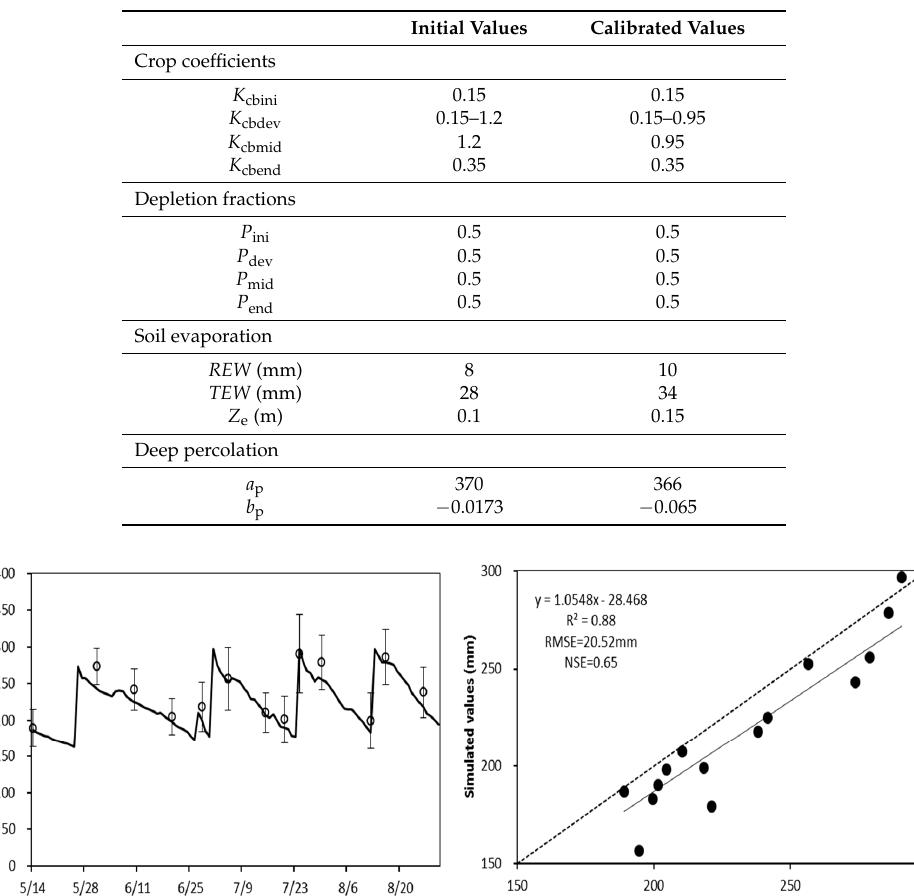
Table 3. Initial and calibrated values of the crop and soil parameters appropriate for maize for seed: crop coefficients, depletion fractions under conditions of no stress, soil evaporation and deep percolation parameters.